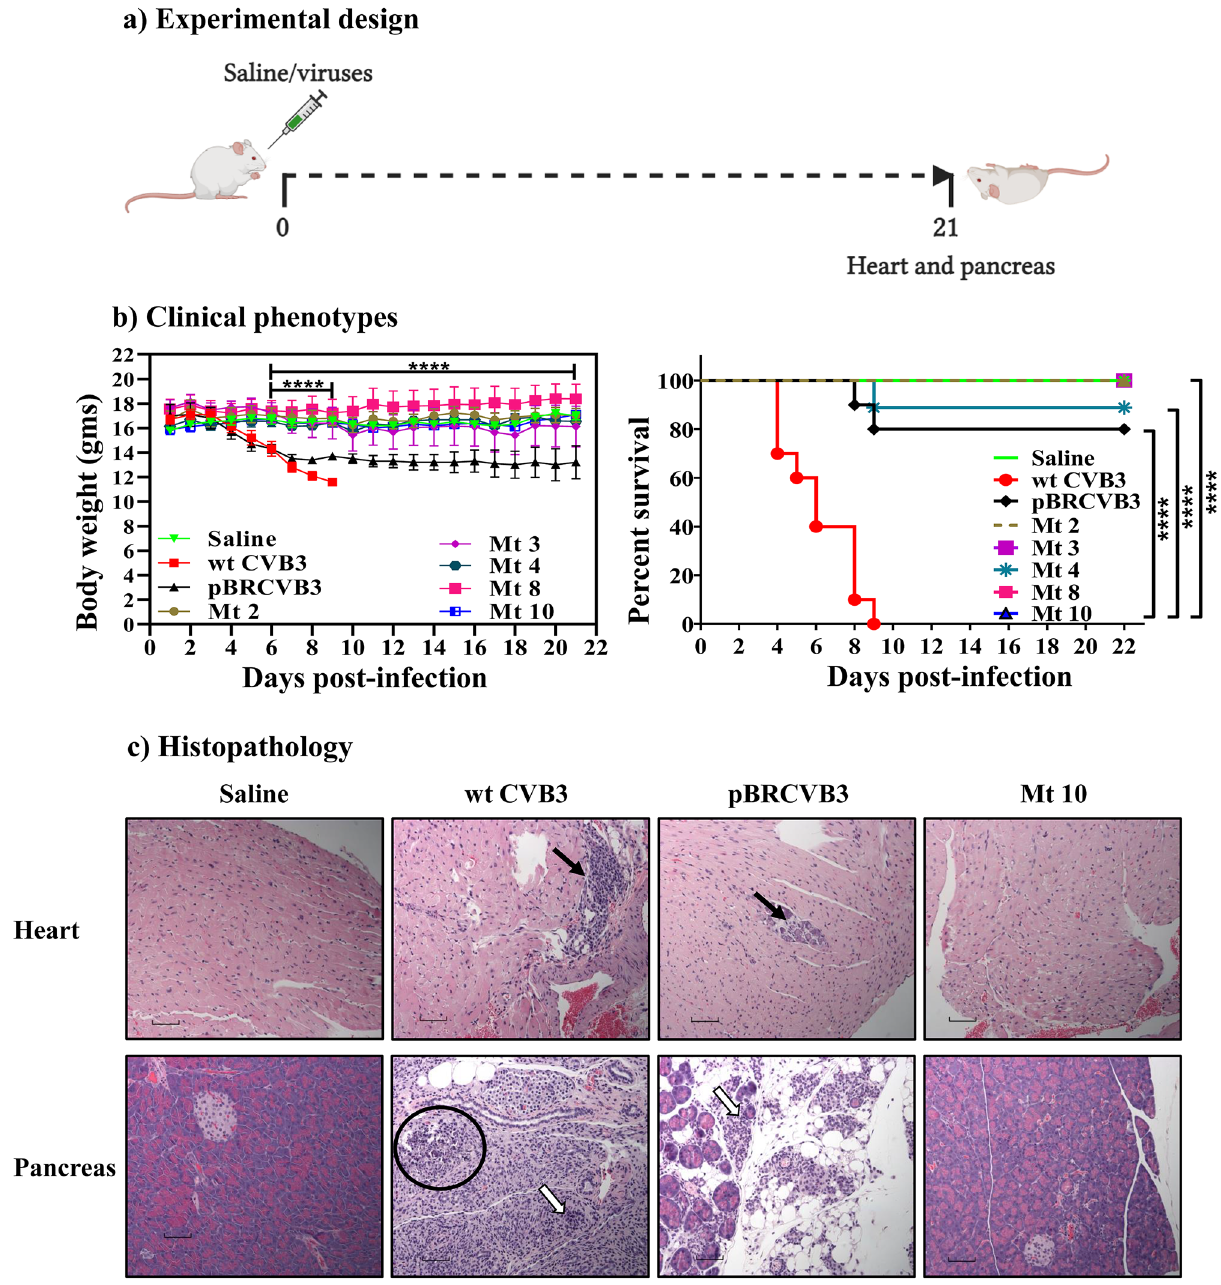
Figure 3. Disease phenotypes induced by various mutant viruses. ( a ) Experimental design. A/J mice were infected with wt CVB3, pBRCVB3, Mt 2, Mt 3, Mt 4, Mt 8, and Mt 10 viruses, with saline recipients as controls. At termination on day 21, heart and pancreas were collected for histology. ( b ) Clinical phenotypes. Body weights were taken every one to two days until termination and compared between groups (left panel); mortalities, if any, were noted to calculate survival rates (right panel). ( c ) Histopathology. Hearts and pancreata collected at termination on day 21 were processed for standard histology to evaluate inflammatory changes. Representative sections of hearts (top panel) and pancreata (bottom panel) from saline (negative control), wt CVB3 and pBRCVB3 (positive controls), and Mt 10 virus groups are shown. Solid and empty arrows represent infiltrations of MNCs in the heart and pancreatic sections, respectively. Circles indicate necrotic areas in the pancreatic sections. Magnification, 20×; scale bars, 20 µm. Data sets obtained from two individual experiments, each involving n = 4 to 5 mice, are shown. Two-way ANOVA with a Sidak’s post-test was used to compare body weight changes in saline group relative to wt CVB3/pBRCVB3 groups. Log-rank test with Bonferroni correction was used to compare survival curves. **** p ≤